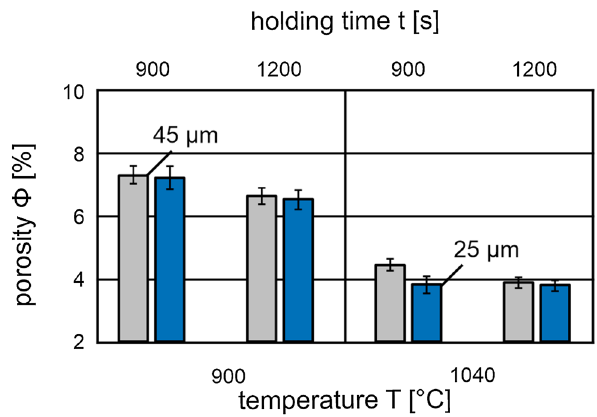
Fig. 4 The porosity of the investigated composite samples sintered at temperatures of 900 °C and 1040 °C at holding times of 900 s and 1200 s using chromium powder with a particle size of 45 µm and 25